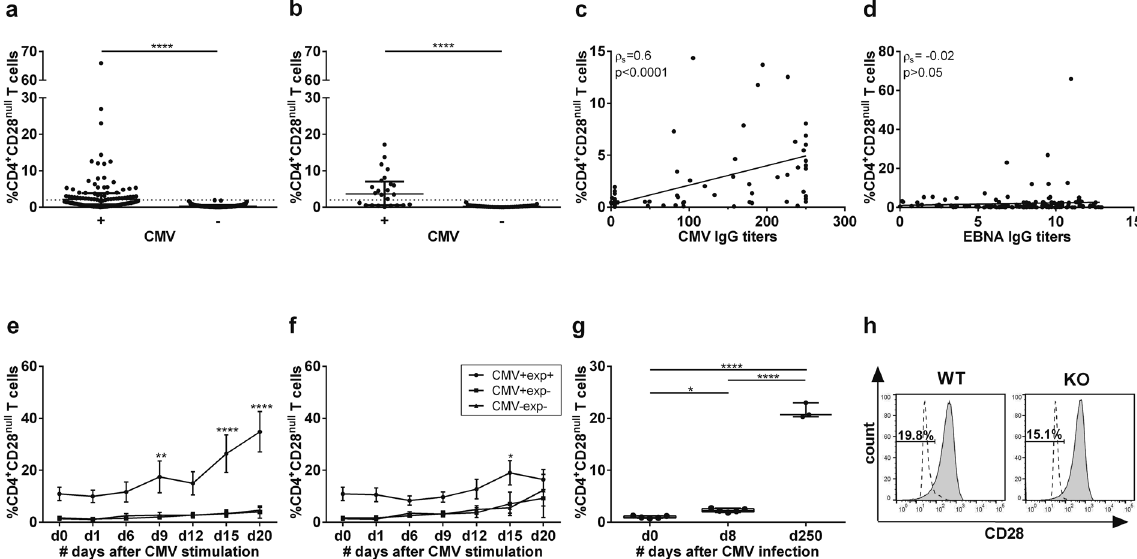
Figure 1. CMV infection expands CD4 + CD28 null T cells. Flow cytometry was performed to determine the percentage of CD4 + CD28 null T cells. CMV and EBV status and immunoglobulin titers were determined via ELFA. CD4 + CD28 null T cells in ( a ) CMV seropositive (n = 100) compared to seronegative (n = 127) MS patients and ( b ) CMV seropositive (n = 24) versus seronegative healthy controls (n = 39). ( c ) Correlation of CMV IgG levels with the percentage of CD4 + CD28 null T cells in MS patients and HC (n = 140). ( d ) Correlation of EBV EBNA IgG titers in 155 MS patients. ( e ) Repeated stimulation of PBMCs from HC (n = 12) and MS patients (n = 8) with CMV pp65 ( e ) or IL-2 ( f ) in vitro , after which the number of CD4 + CD28 null T cells was determined at different time points. ( g ) Flow cytometry of splenocytes of MCMV infected mice on day 0, day 8 and day 250 post infection (n = 5/time point). ( h ) Splenocytes from MCMV-infected WT (n = 5) and CD80/86 − / − (n = 4) mice were analysed for the percentage of CD4 + CD28 null T cells at day 250 post infection. * p < 0.05, ** p < 0.01, **** p <